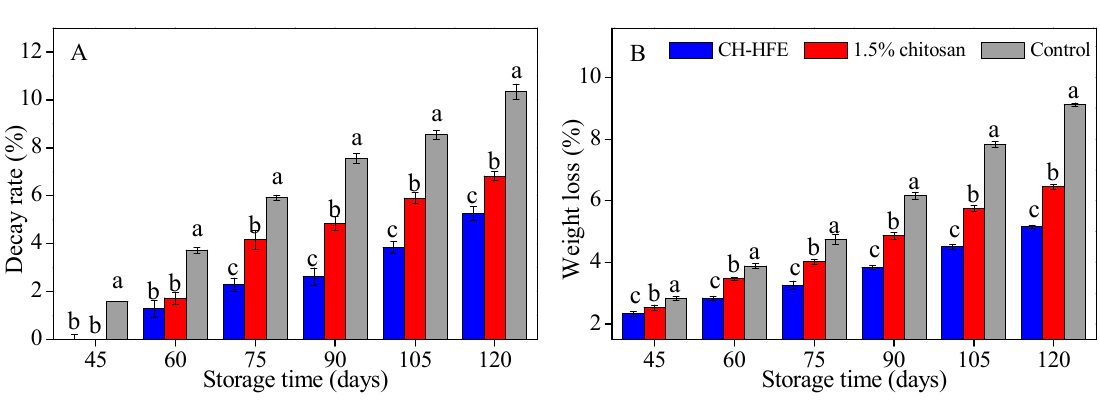
Figure 2. Changes in decay rate ( A ) and weight loss ( B ) of navel orange fruits stored at 5 °C for 120 days. Bars indicate standard error of three